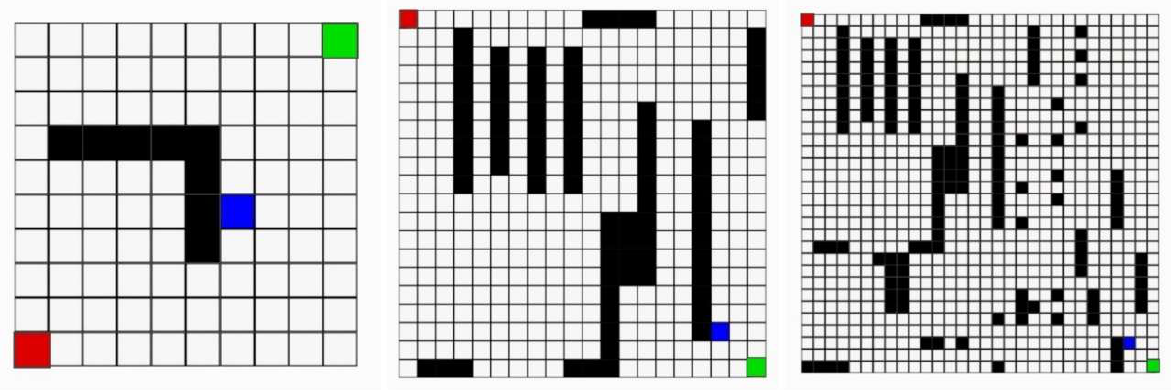
Figure 10. Raster maps. The red raster is the starting point, the green raster is the ending point, the black raster is the static obstacle, and the blue raster is the dynamic obstacle.